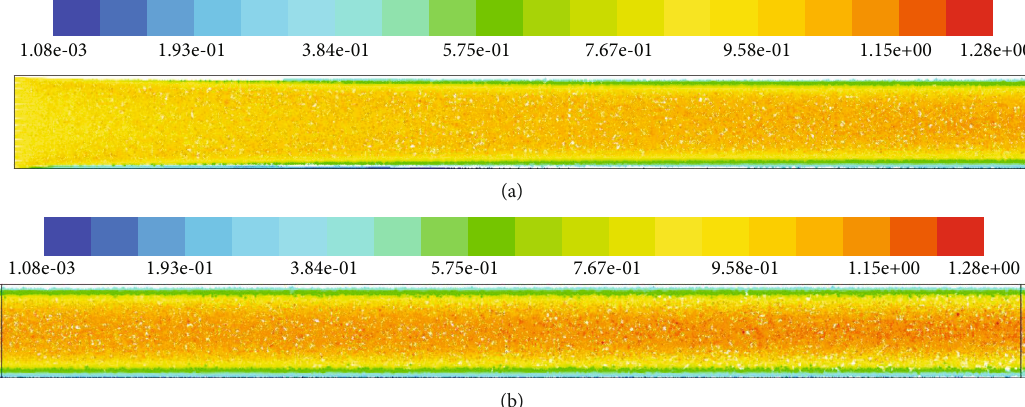
≤ 40mm fracture 1